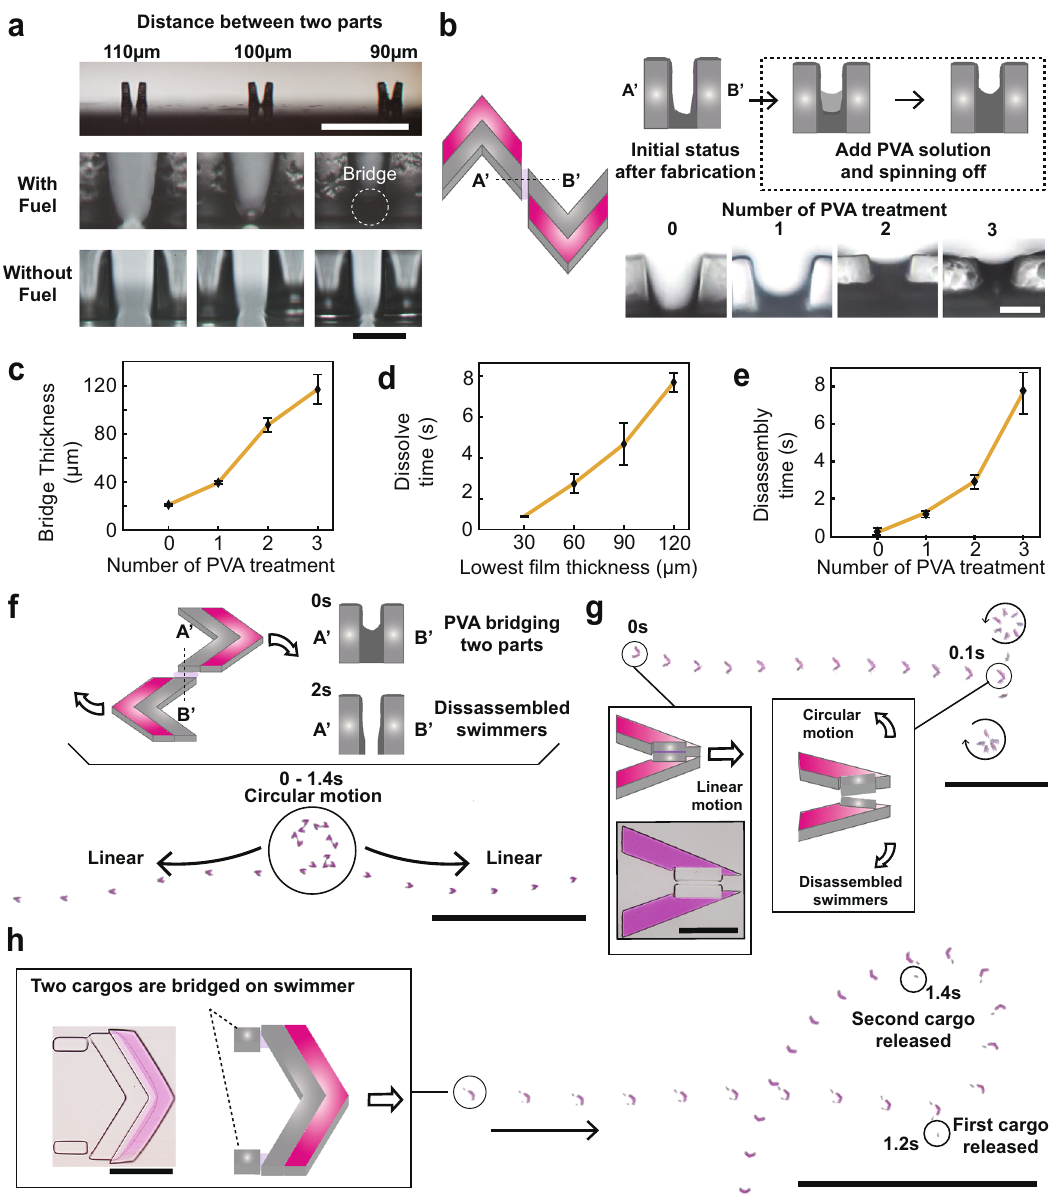
Fig. 4 Disassembly and motion change of swimmers after a designated time. a By changing the distance between fuel parts to 100 µ m, we were able to fabricate a water-soluble PVA bridge between these parts. 1 cm (white) and 100 µ m (zoom-out pictures). b , c By controlling the thickness of the PVA bridge via the PVA layer stacking procedure, the thickness of the PVA bridge was increased ( n = 10). Scale bars represent 100 µ m. The error bars represent s.d. d As the thickness of the PVA fi lm increased (Supplementary Fig. 9), the dissolution time needed to generate a 90 µ m hole on the fi lm increased ( n = 10). The error bars represent s.d. e The disassembly time of the two rocket-like swimmers that were bridged was controlled based on the number of PVA treatments ( n = 10). The error bars represent s.d. f By bridging the two linear-propelling swimmers moving in opposite directions, disassembly and a change in motion (from circular to linear) were demonstrated. Scale bar represents 500 µ m (black boxes) and 1 cm (zoom-out pictures). g By bridging the bar-shaped swimmers in a rocket-shape, a change in motion from linear to circular was possible. Scale bar represents 500 µ m (black boxes) and 1 cm (zoom-out pictures). h Cargo delivery concept. Two hydrogel cargos were bridged on single linear-propelling swimmers and released after the designated time. Scale bars represent 500 µ m (zoom-in picture) and 1 cm (zoom-out picture). For microswimmers used for the c , e , one layer of PVA stacking was